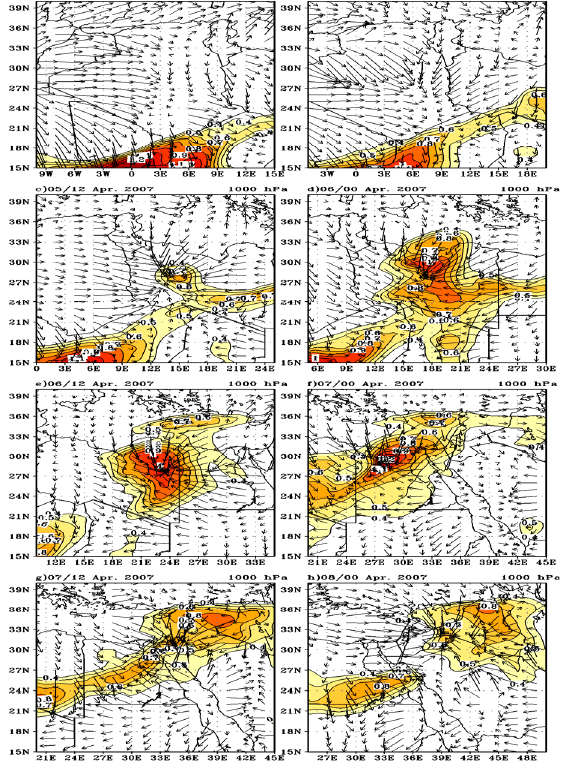
Figure 14. Horizontal distribution of dust aerosol optical depth at 550 nm (colored regions) and divergent components of wind (m/s) (black arrow) at 1000 hPa for 12Z and 00Z from 4 to 8 April 2007.